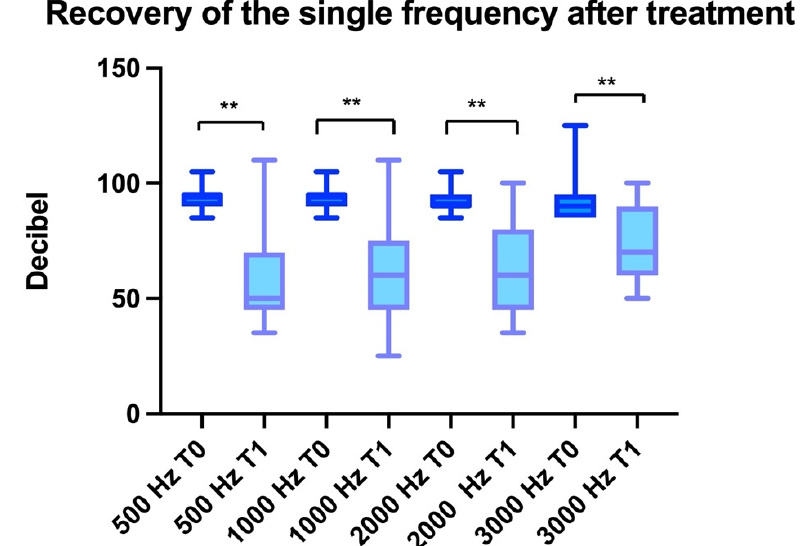
Figure 2. The improvement in the auditory thresholds of each frequency obtained after surgery, comparing the baseline with hearing aids and post-treatment (stapedectomy plus hearing aids). “**” indicates p < 0.01.